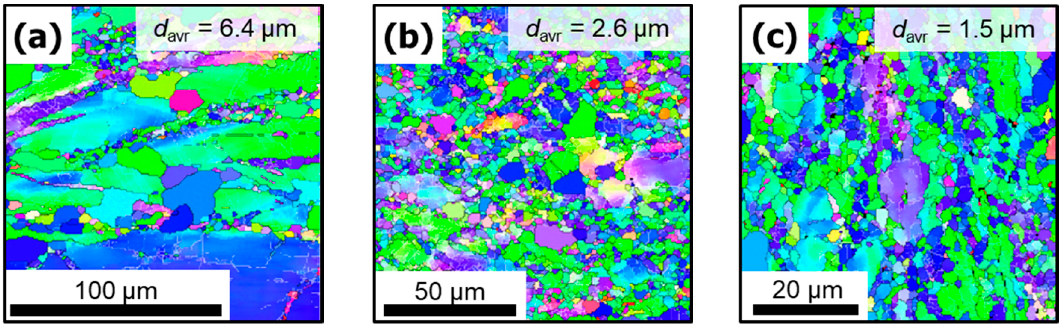
Figure 3. EBSD inverse pole figure maps of the investigated TM11 Mg alloys: ( a ) TM11-1P, ( b ) TM11-3P, and ( c ) TM11-5P. The images are normal to RD. “ d avr ” indicates the average grain size, as determined by the EBSD analysis.